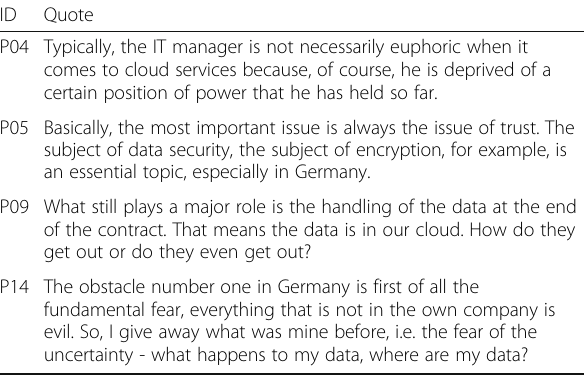
Table 5 Quotes related to security concerns, ownership, and loss of power (translated by the